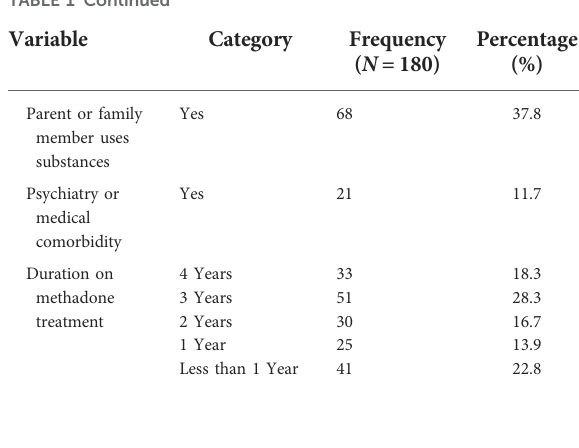
TABLE 1 Sociodemographic characteristics of study